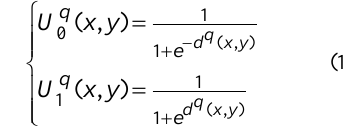
Fig. 4. the function diagram of